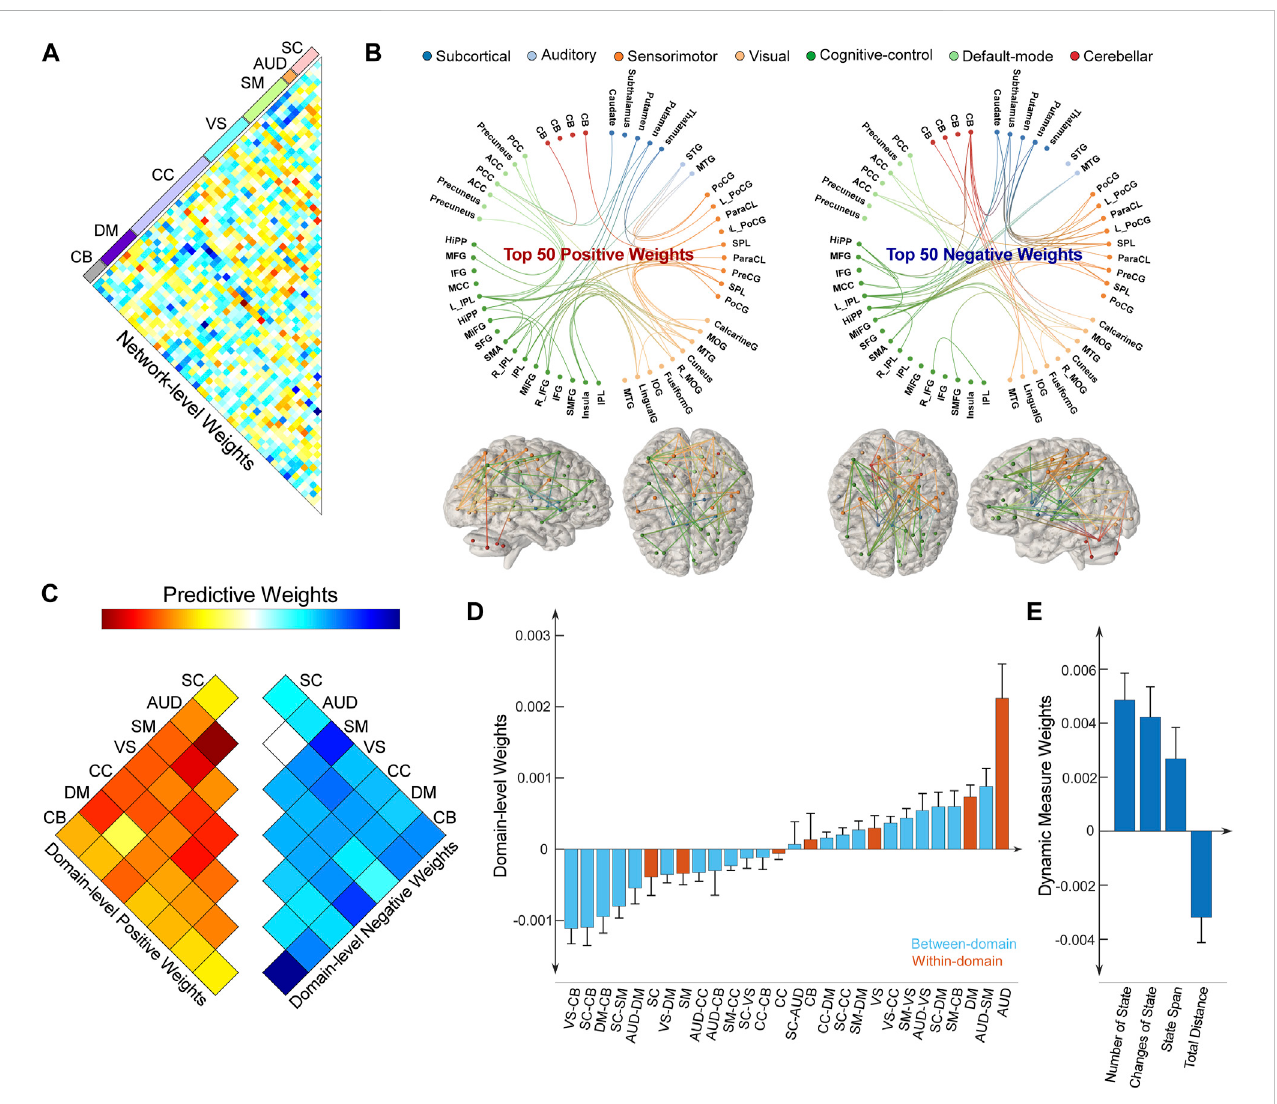
FIGURE 4 Distributions of weight maps in predicting antidepressant outcomes (HDRS 24 composite score). (A) Distributions of raw predictive weights at the FNC pair level averaged across 10,000 CV rounds. (B) Functional connectome plots with the top 50 positive weights and top 50 negative weights. ICNs are arranged into seven functional domains with different colors. (C) The cell plots show the domain-level representation of the predictive weights. For each pair of domains (between-domain and within-domain), we averaged predictive weights of all sFNC belonging to that domain pair. Positive weights and negativeweightswereseparatelysummarizedforeachdomainpairtodemonstratetheirrelativecontribution. (D) Meanweightsdistributionofwithin-domain and between-domain sFNC in the predictive models. Error bars indicate standard deviation. (E) Mean weights distribution of dFNC features in the predictive